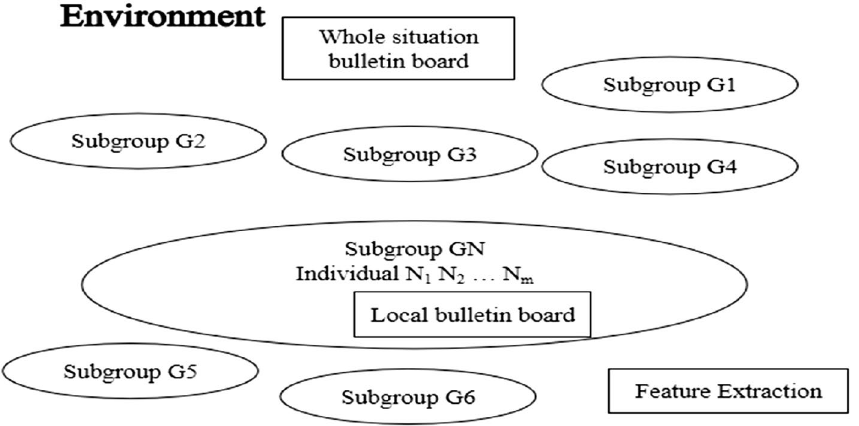
Figure 2. MEA algorithm